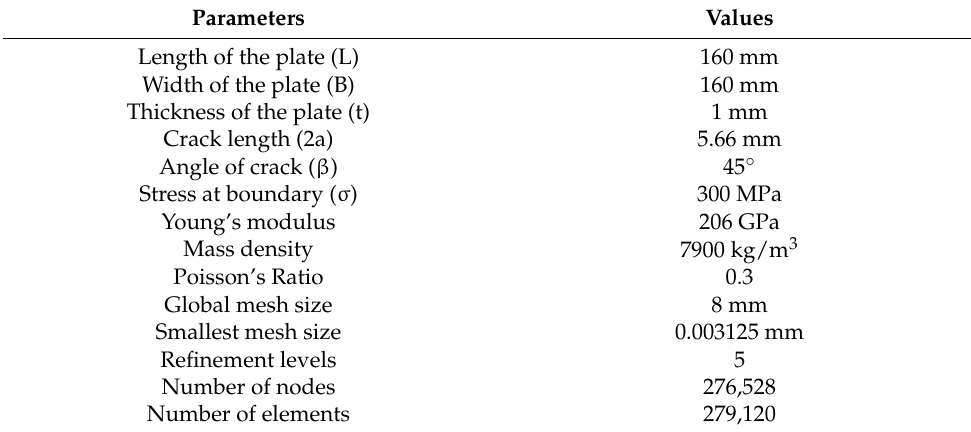
Table 2. Configuration of the simulation.